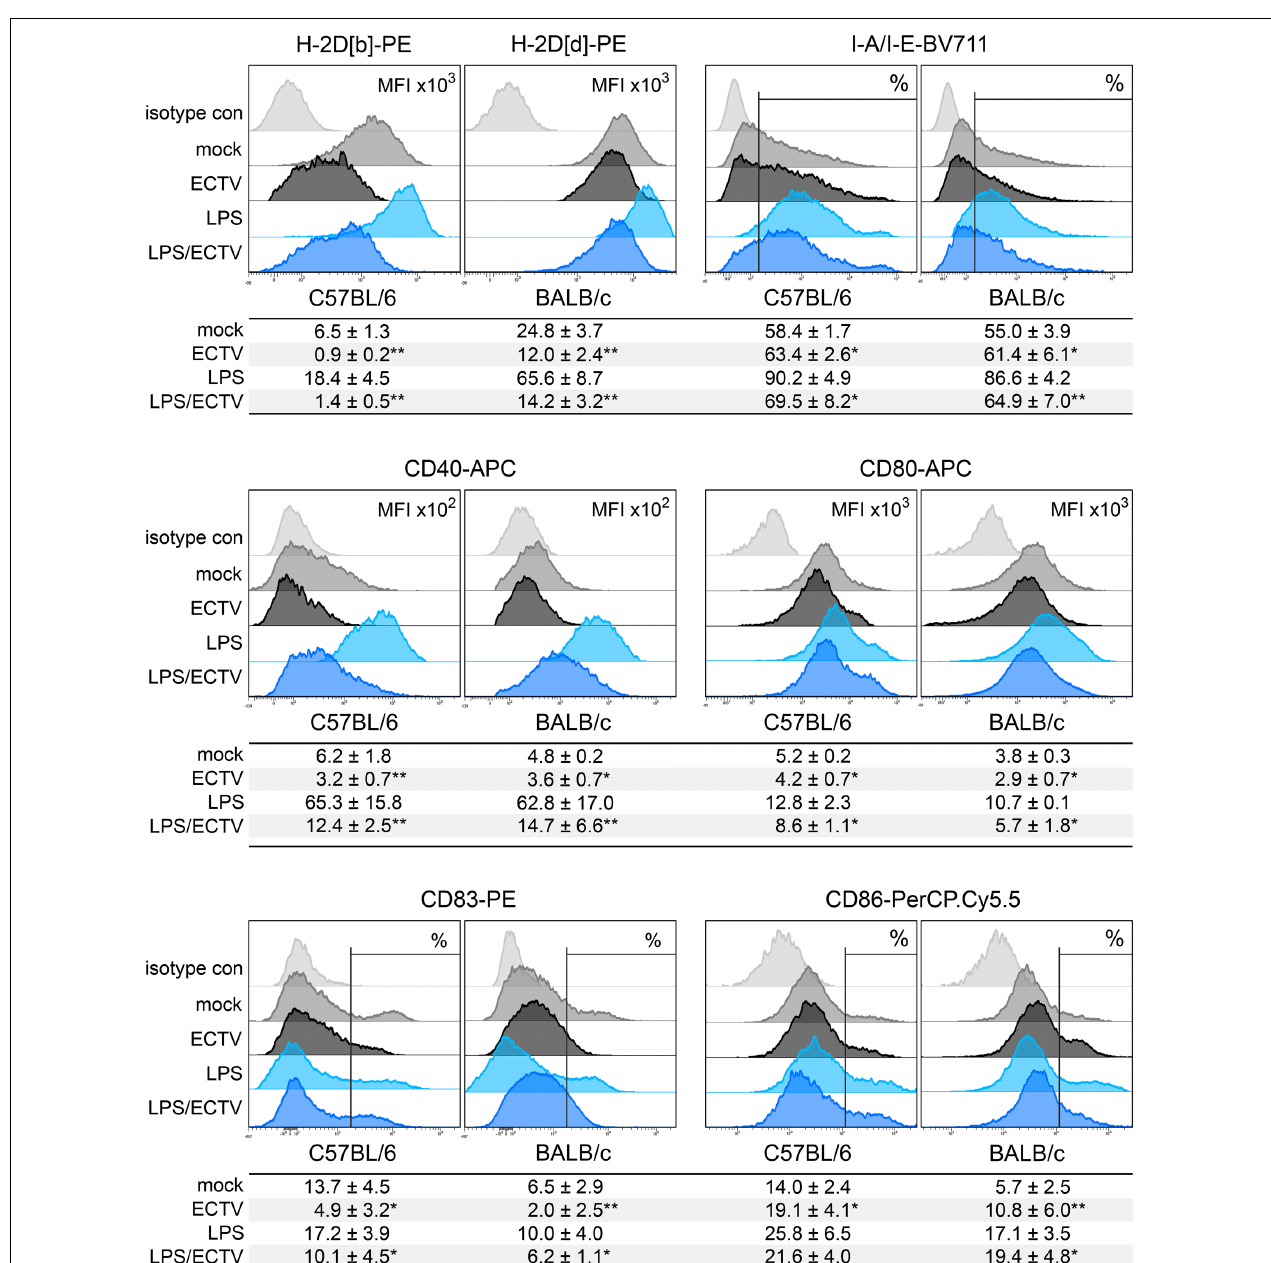
FIGURE 8 | ECTV infection inhibits maturation of GM-BM in a mouse strain-independent manner. Representative flow cytometry histograms showing the effect of ECTV infection and/or LPS treatment on maturation marker expression in GM-BM from C57BL/6 and BALB/c mice at 24 hpi. Below each histogram set is a table with mean values ( ± SD) for a given marker from at least three independent experiments. The expression is presented as mean fluorescent intensity (MFI) or the percentage of positive cells for a given marker (paired Student’s t -test; ∗ P < 0.05, ∗∗ P <